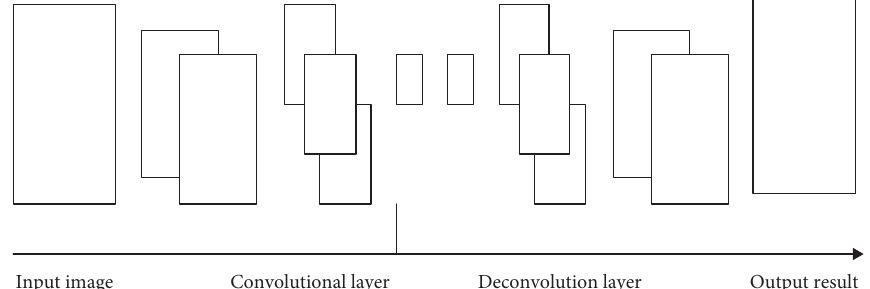
Figure 1: Model building process.